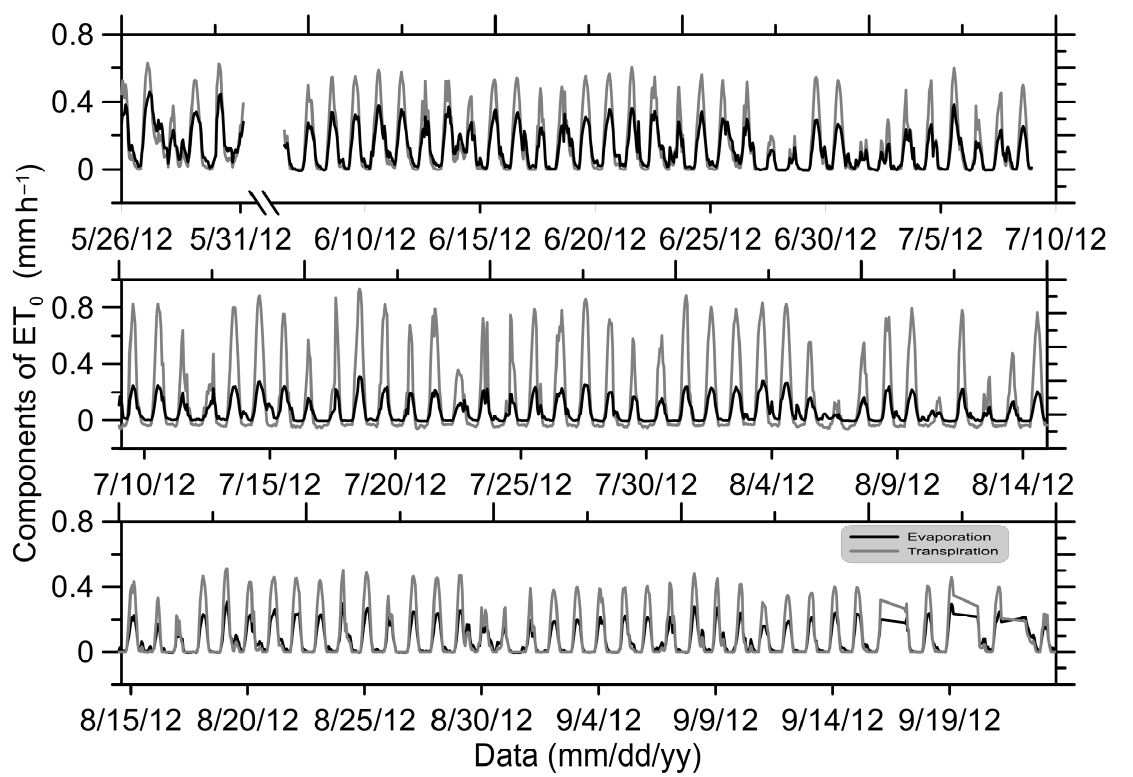
Figure 4. Seasonal variations in reference evapotranspiration (ET 0 ) components as simulated by the reference soil–plant– atmosphere continuum (R-SPAC) model over the growing season. The gray line represents shows transpiration, whereas the black line represents reference evaporation. Table 2. Mean and standard deviation in sensitivity coefficient (S i ) of reference evapotranspiration (ET 0 ) and its components (T 0 and E 0 ) to the measured